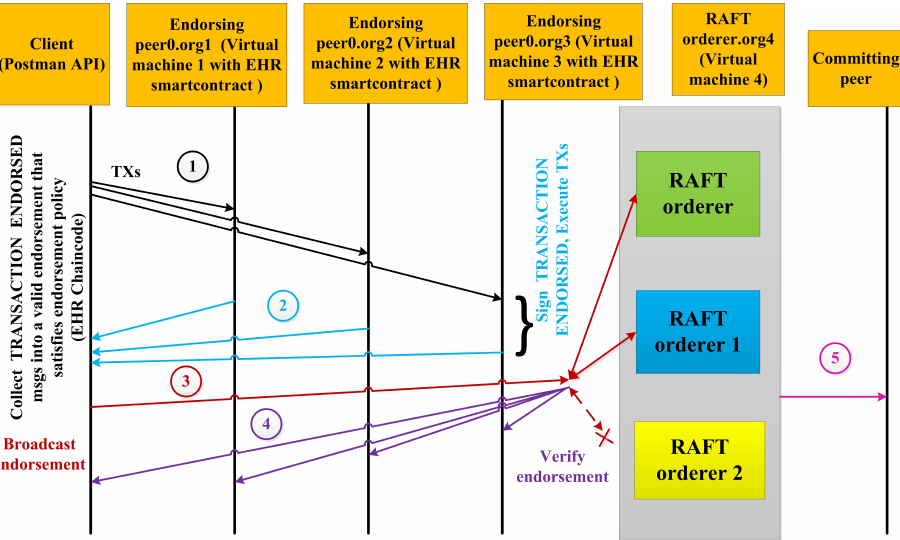
Figure 2. Transaction flow sequence in the proposed